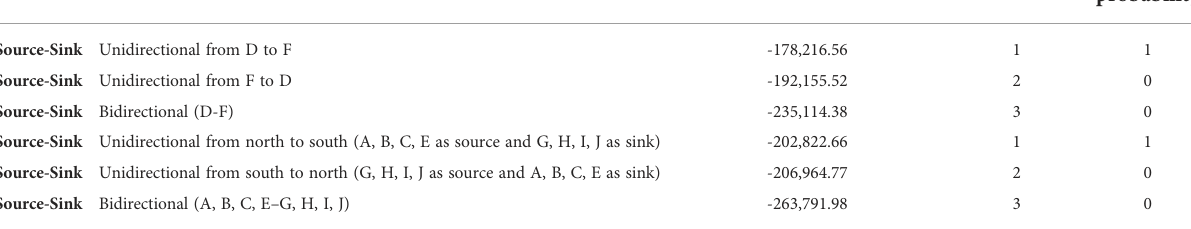
Model Directionality Bezier approximation score Model choice Model